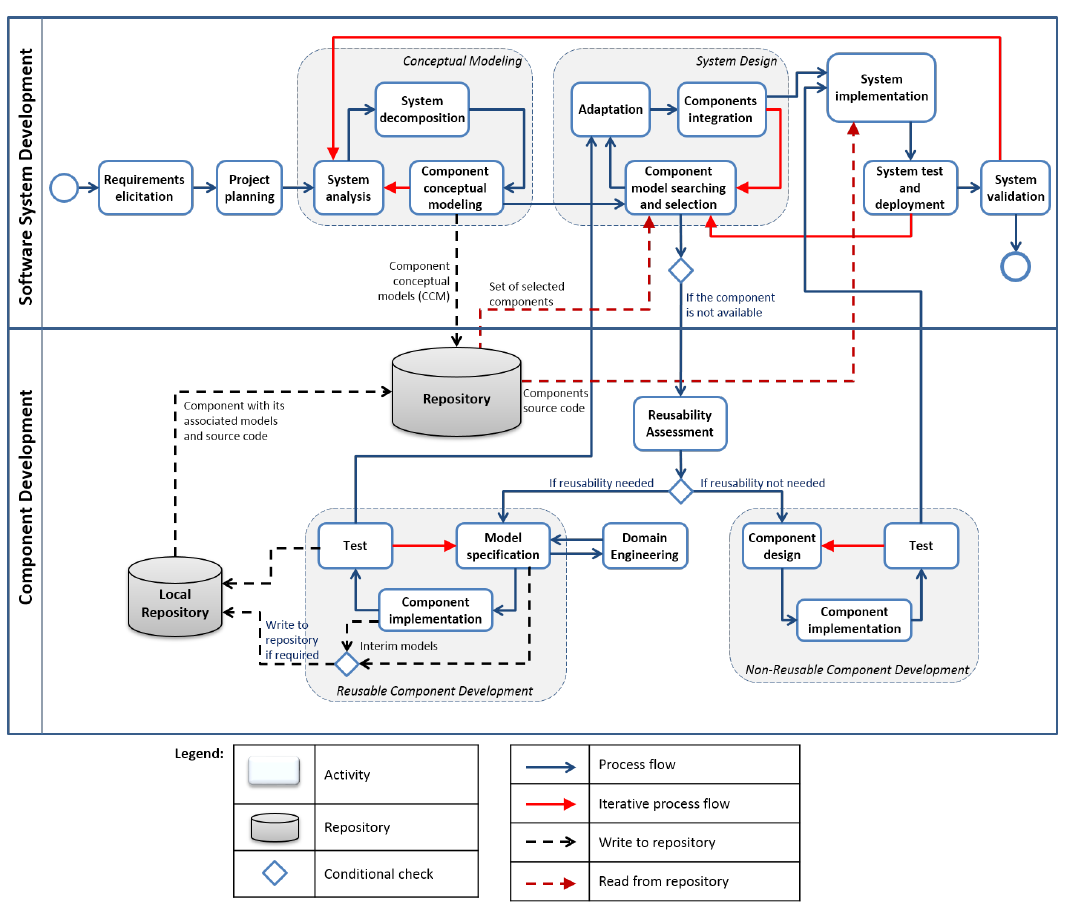
Figure 1. CompoMDD process